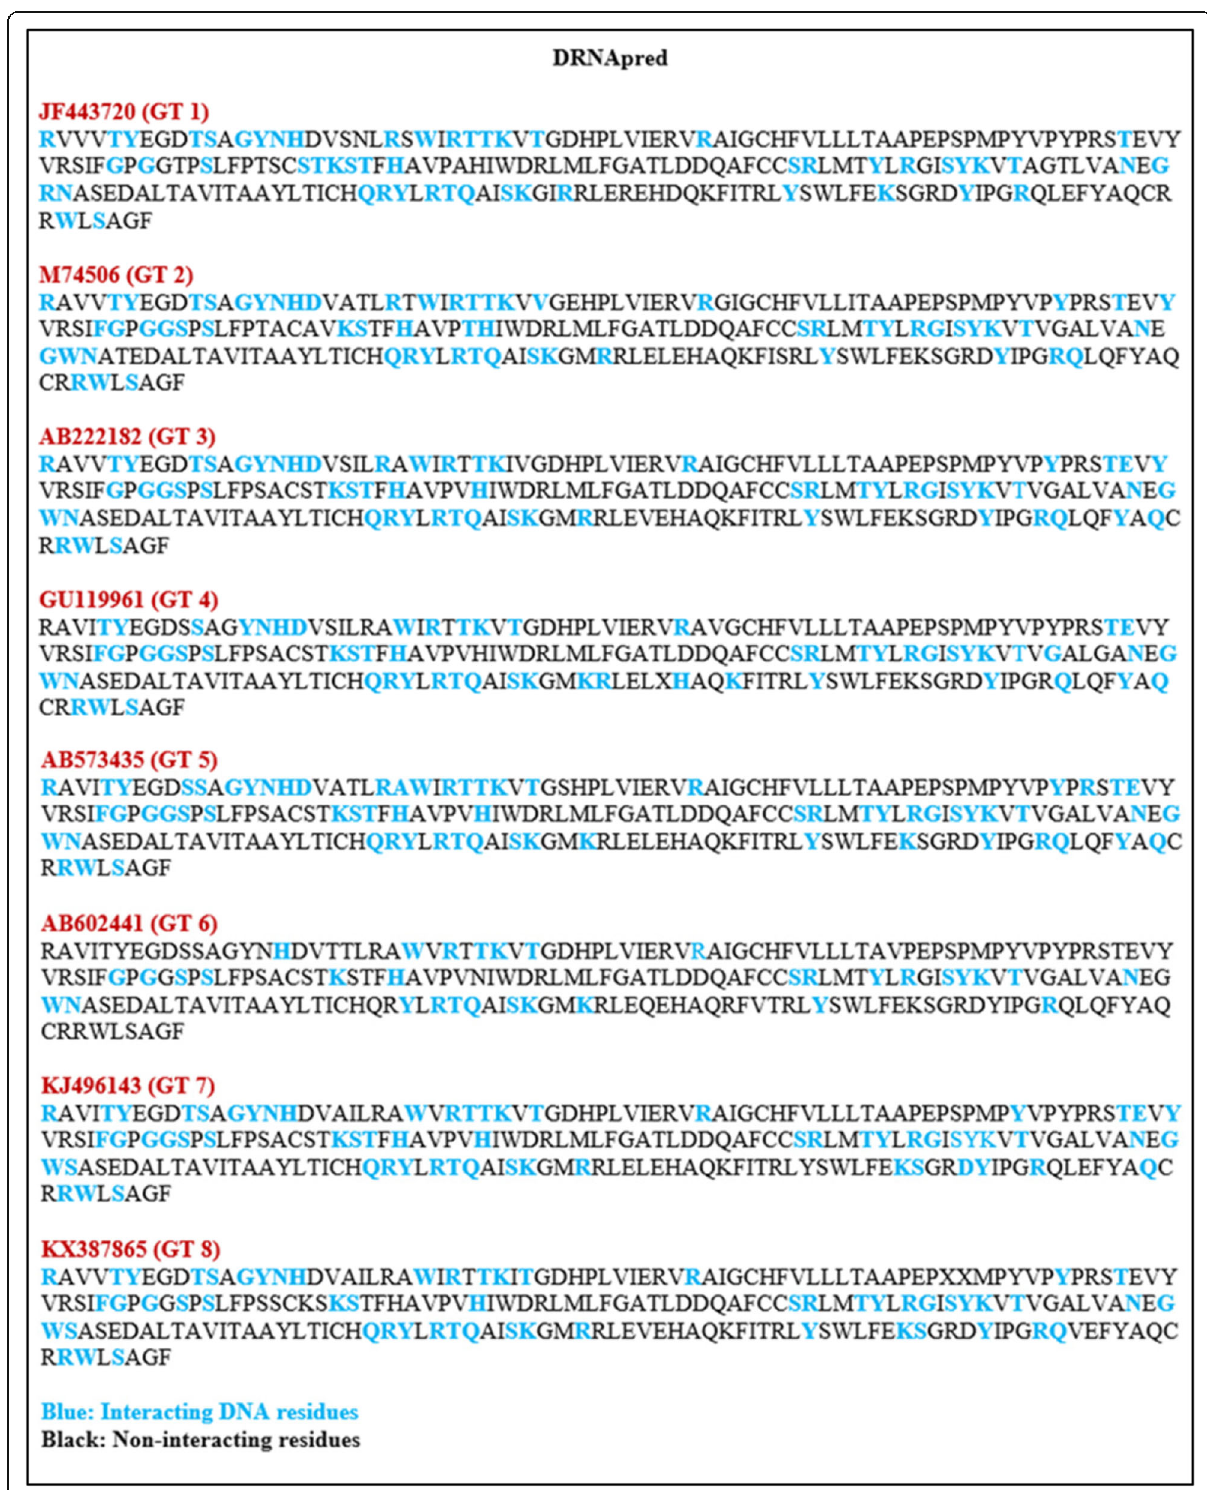
Fig. 7 Analysis of DNA-binding propensity of HEV YDR, i.e., JF443720 (GT 1), M74506 (GT 2), AB222182 (GT 3), GU119961 (GT 4), AB573435 (GT 5), AB602441 (GT 6), KJ496143 (GT 7), and KX387865 (GT 8). The resulting DNA-binding profile was calculated using webservers DRNApred. The DNA- binding residues distributed throughout the polypeptide chains of the YDR